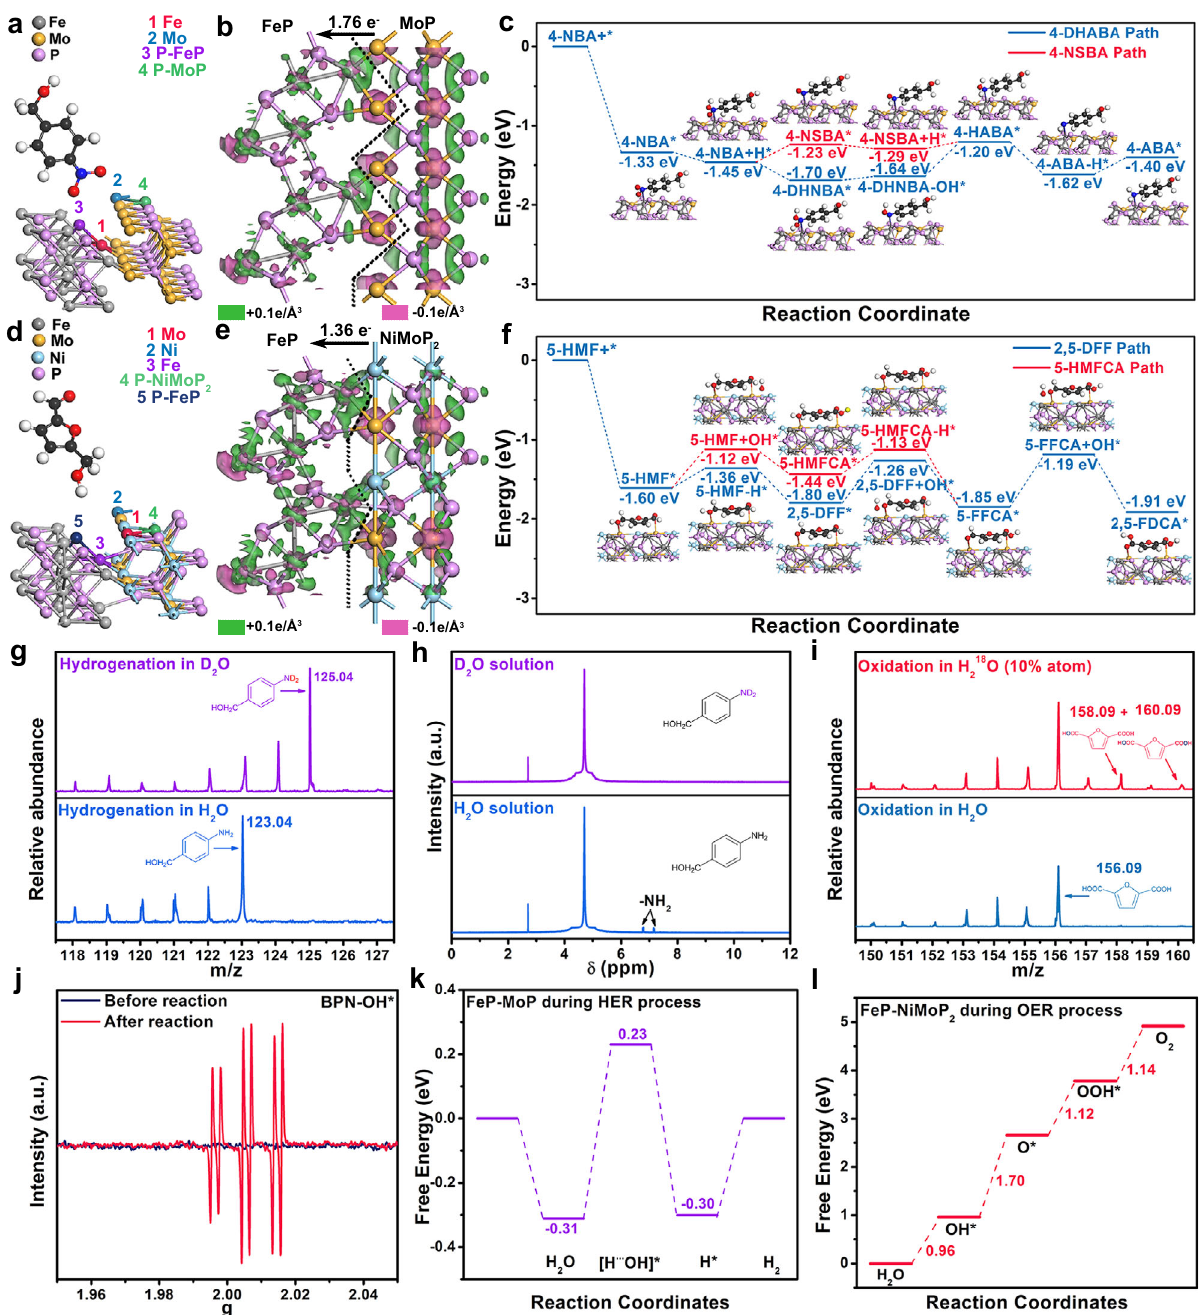
Fig. 6 DFT theoretical calculation, and study of water as sole H and O sources. a Possible adsorption sites of 4-NBA on the surface of FeP-MoP. b Electron density difference plot of FeP-MoP, c Energy pro fi les of 4-NBA reduction to 4-ABA on the FeP-MoP surface. d The possible adsorption sites of 5-HMF on the surface of FeP-NiMoP 2 . e Electron density difference plot of FeP-NiMoP 2 . f Energy pro fi les of 5-HMF oxidation to 2,5-FDCA on the FeP- NiMoP 2 surface. g ESM and h 1 H-NMR spectra of the fi nal product of 4-NBA EHR in H 2 O (bottom) and D 2 O (top) solution. i ESM spectra of the fi nal product of 5-HMF EOR product in H 2 O (bottom) and H 2 18 O (top) solution. j ESR detection of PBN- (cid:129) OH for FeP-NiMoP 2 /FNF in H 2 O solution before and after 5-HMF EOR. k Free energy diagram for HER on the FeP-MoP. l Free energy diagram for OER on FeP-NiMoP 2